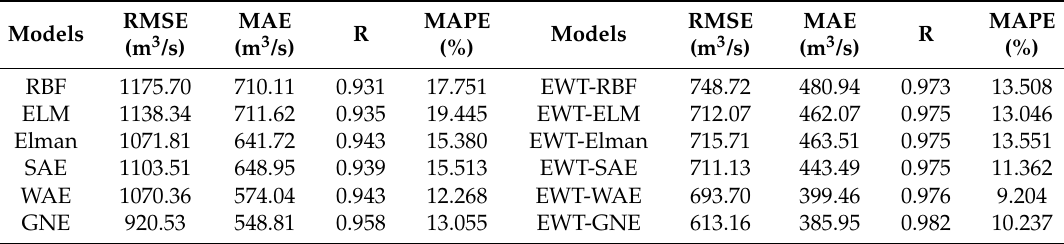
Table 2. The forecasting results of the models in the training period.